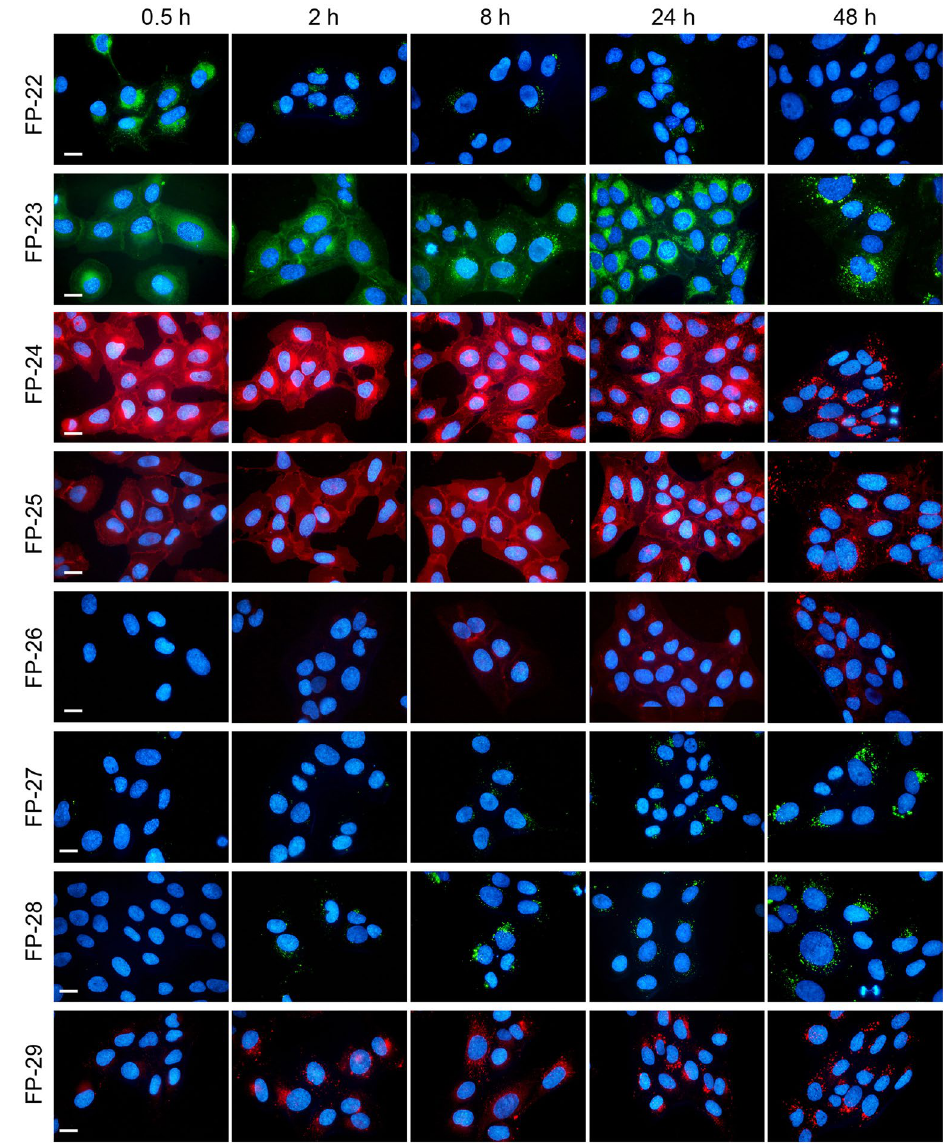
Figure 5. Cellular uptake and distribution of probes FP-22 ‒ FP-29. Cells were loaded with 200 nM probes and representative images of the localization of fluorescent probes in cells were taken at indicated times 0.5, 2, 8, 24, and 48 h. Nuclei stained with Hoechst 33342 are blue. Scale bar 10